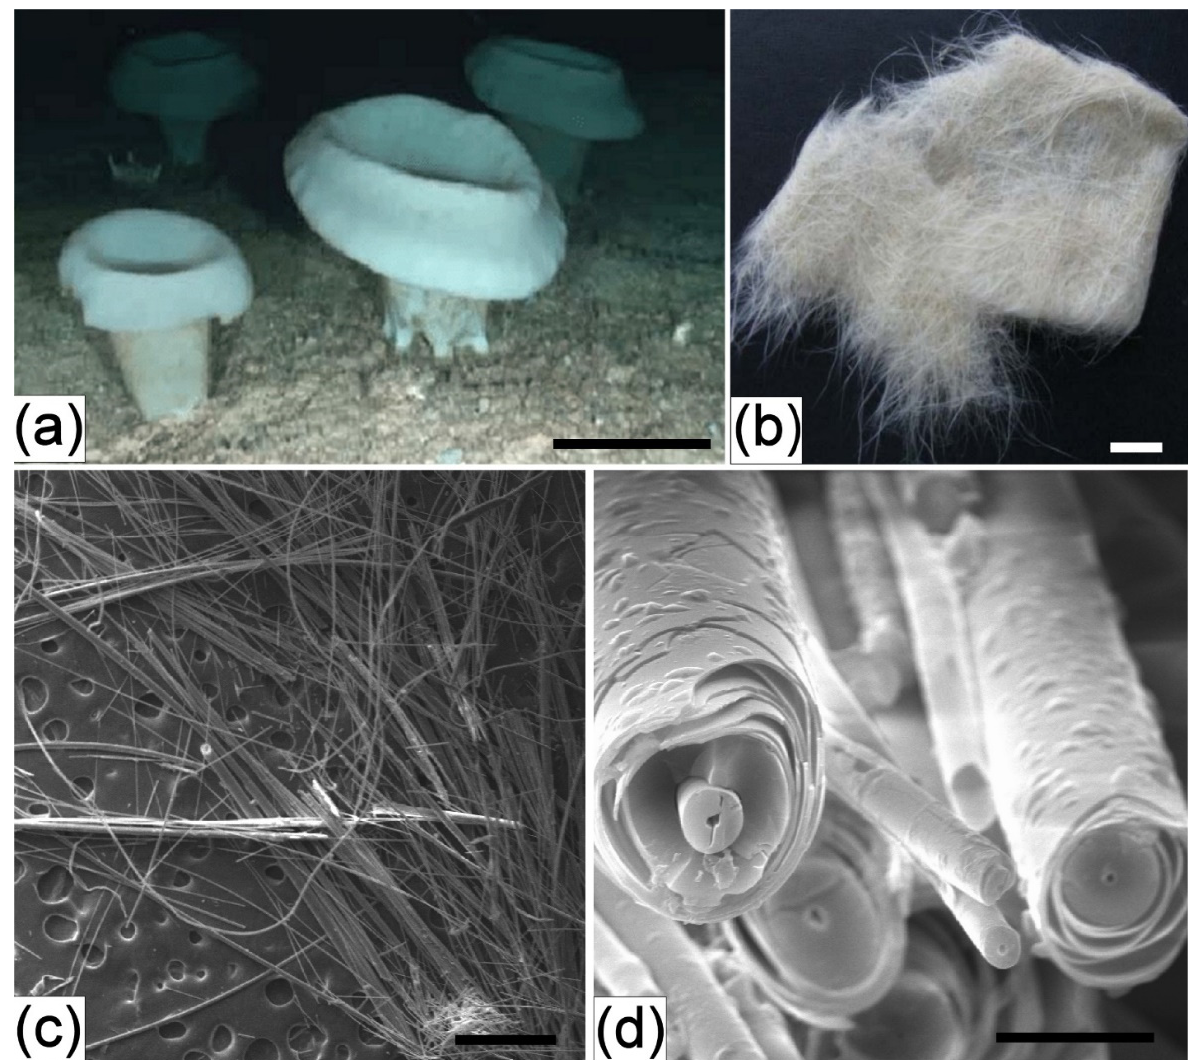
Figure 4. Asconema setubalense. Morphological feature ( a ), dry felt ( b ), and the ultrastructure of the spicules by SEM ( c , d ). Scale: ( a )—40 cm, ( b )—30 mm, ( c )—600 μ , ( d )—20 μ .